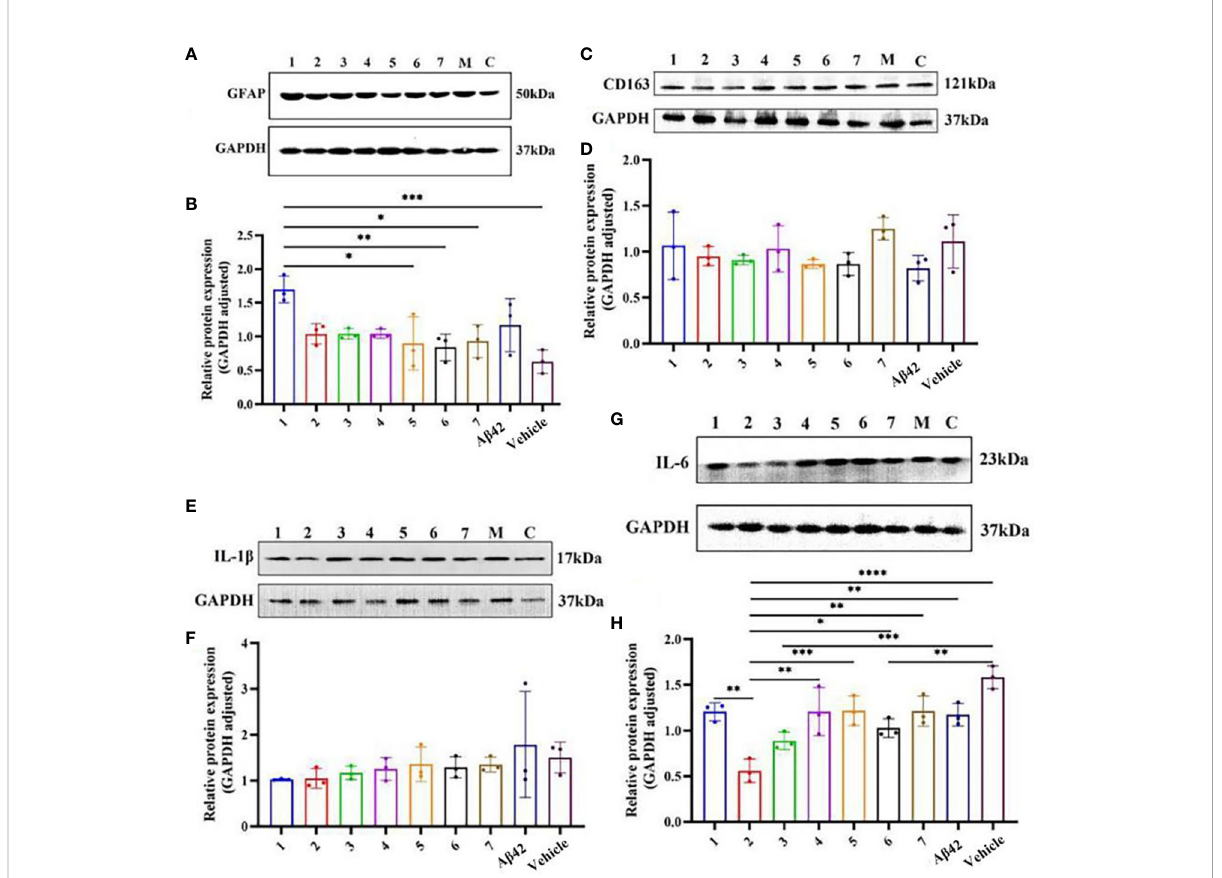
FIGURE 6 Effects of drugs on the expression of in fl ammation-related proteins in brain tissue of AD mouse model. (A, B) Protein expression level GFAP. (C, D) Protein expression level CD163. (E, F) Protein expression level Il-1 b . (G, H) Protein expression level Il-6. 1:Zun-Pre; 2:Zun-Int Ll; 3: Zun-Int M; 4: Zun-Int H; 5: